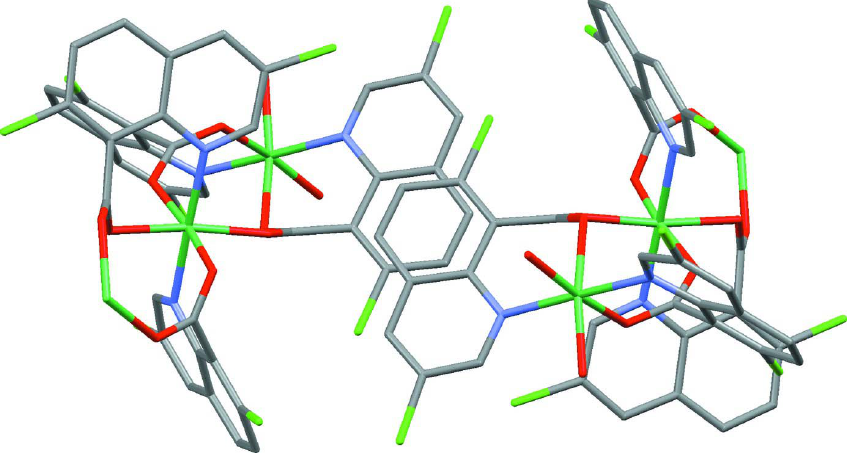
Figure 1 The structure of (I), with the atomic numbering scheme and displacement ellipsoids at the 50% probability level. H atoms have been omitted for clarity [Symmetry code: (i) x ,- y + 1/2, z + 1/2.]